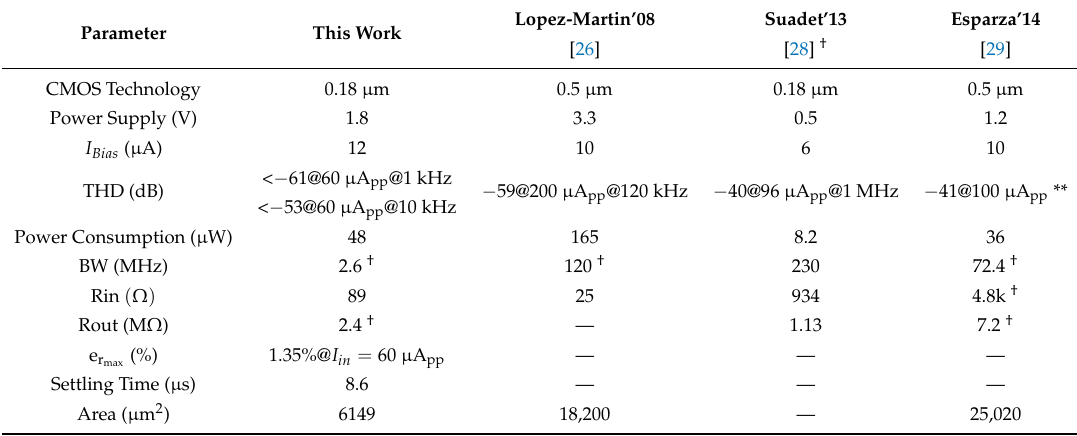
Table 5. Electrical characteristics of the integrated SB-CB prototype and comparison with other circuits.